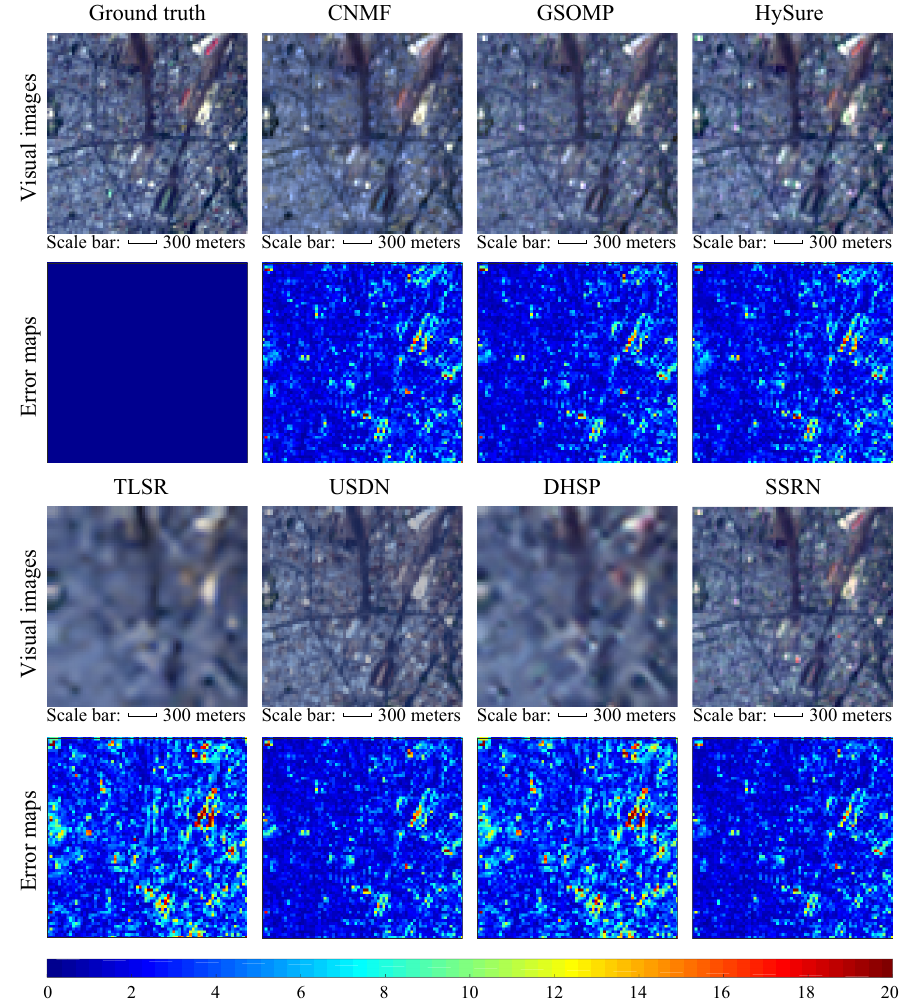
Figure 6. Visual images (R: 24, G: 14, and B: 3) and error maps of the proposed SSRN and the compared methods on the Paris